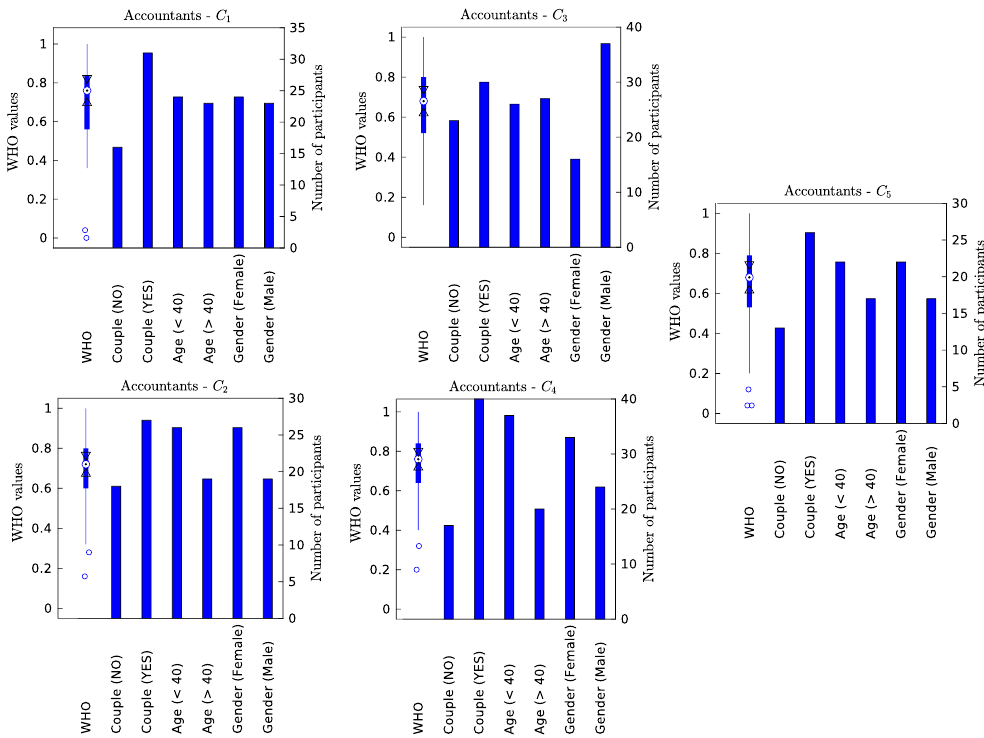
Figure 1. Graphical representation of the main characteristics of the five clusters